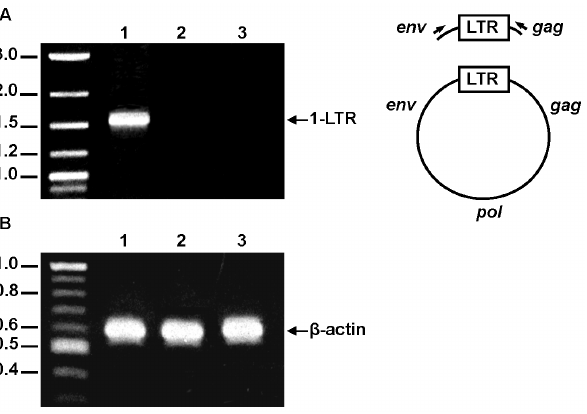
Figure 6. Analysis of the replication capacity of the SIV FIV CA-p1-NC(1–9) chimera in permissive 293Tcells by detecting the nuclear circular forms of unintegrated viral DNA. (A) Left panel: Detection of late RT products at 48 h post-infection of 293T cells with VSV-G-pseudotyped wild-type SIV SMM-PBj (lane 1), VSV-G- pseudotyped SIV FIV CA-p1-NC(1–9) (lane 2), or env -minus SIV SMM-PBj (lane 3). Right panel: Schematic representation of the PCR product resulting from the 1-LTR circle using the 5 9 env - and 3 9 gag -specific primers (denoted as arrows). (B) To control for the amount of total DNA in each sample, a human b -actin gene region was amplified from an aliquot of total DNA from cells infected with VSV-G-pseudotyped wild-type SIV SMM-PBj (lane 1), VSV-G-pseudotyped SIV FIV CA-p1-NC(1–9) (lane 2), or env -minus SIV SMM-PBj (lane 3). The PCR amplifications were performed as explained in Materials and Methods. The reaction products were separated by agarose gel electrophoresis and visualized by ethidium bromide staining. Numbers indicate the positions of the DNA molecular weight markers (in kb).